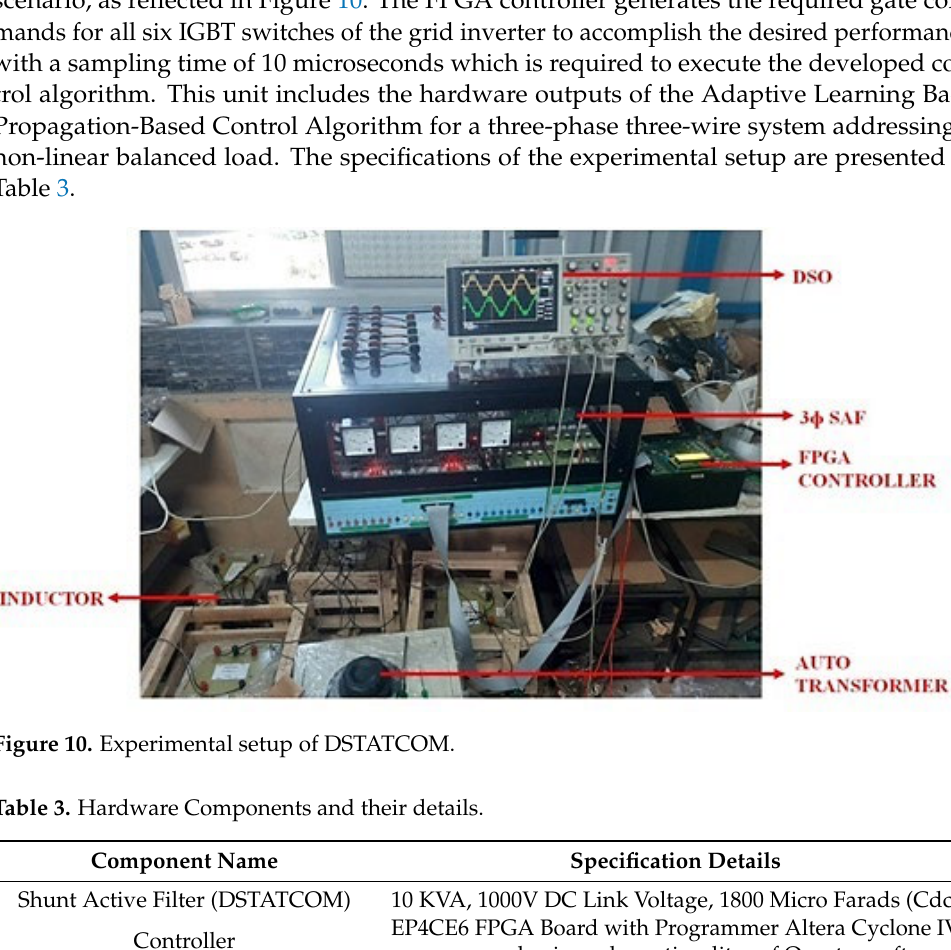
Figure 9. ( a ) THD of A-phase Source current ( b ) THD of B-phase Source current ( c ) THD of C-phase Source current.